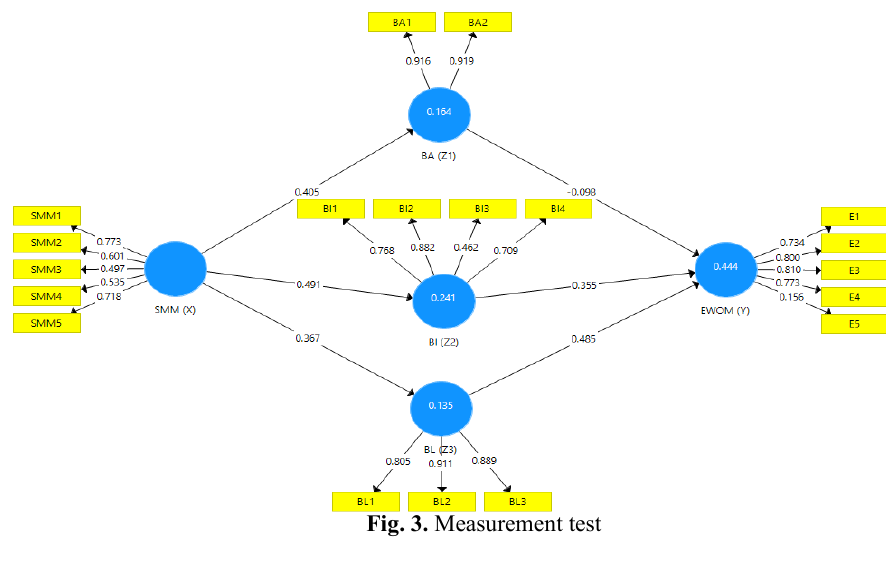
Fig. 3. Measurement